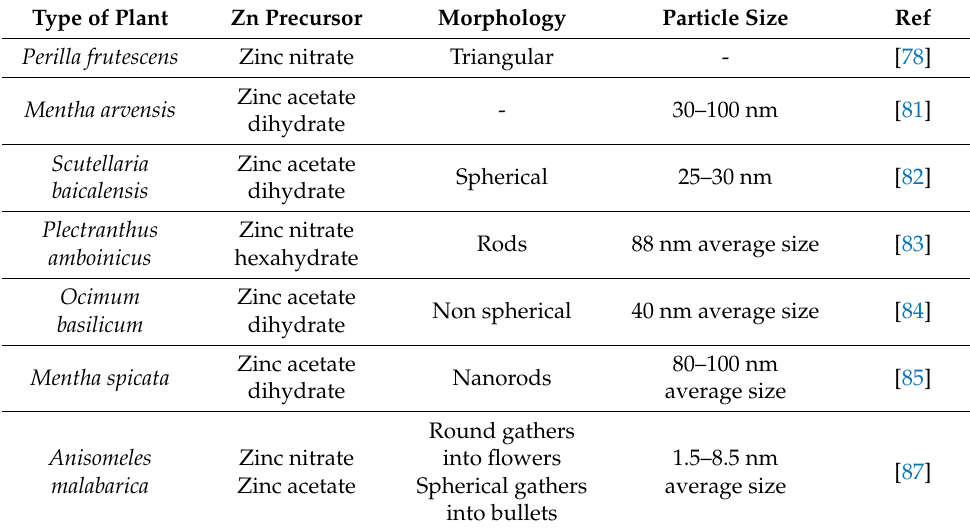
Table 1. Different morphologies of Lamiaceae-mediated synthesis, particle size and the precur- sor